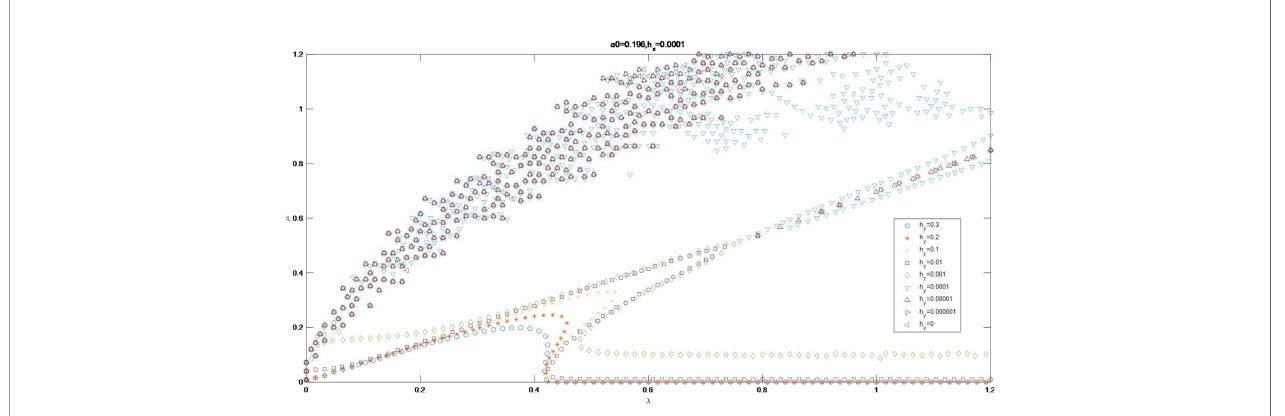
FIGURE 6 | The magni fi ed curves of Im W = 0 for a 0 = 0.196 and ∂ h ∂ x = 0 :